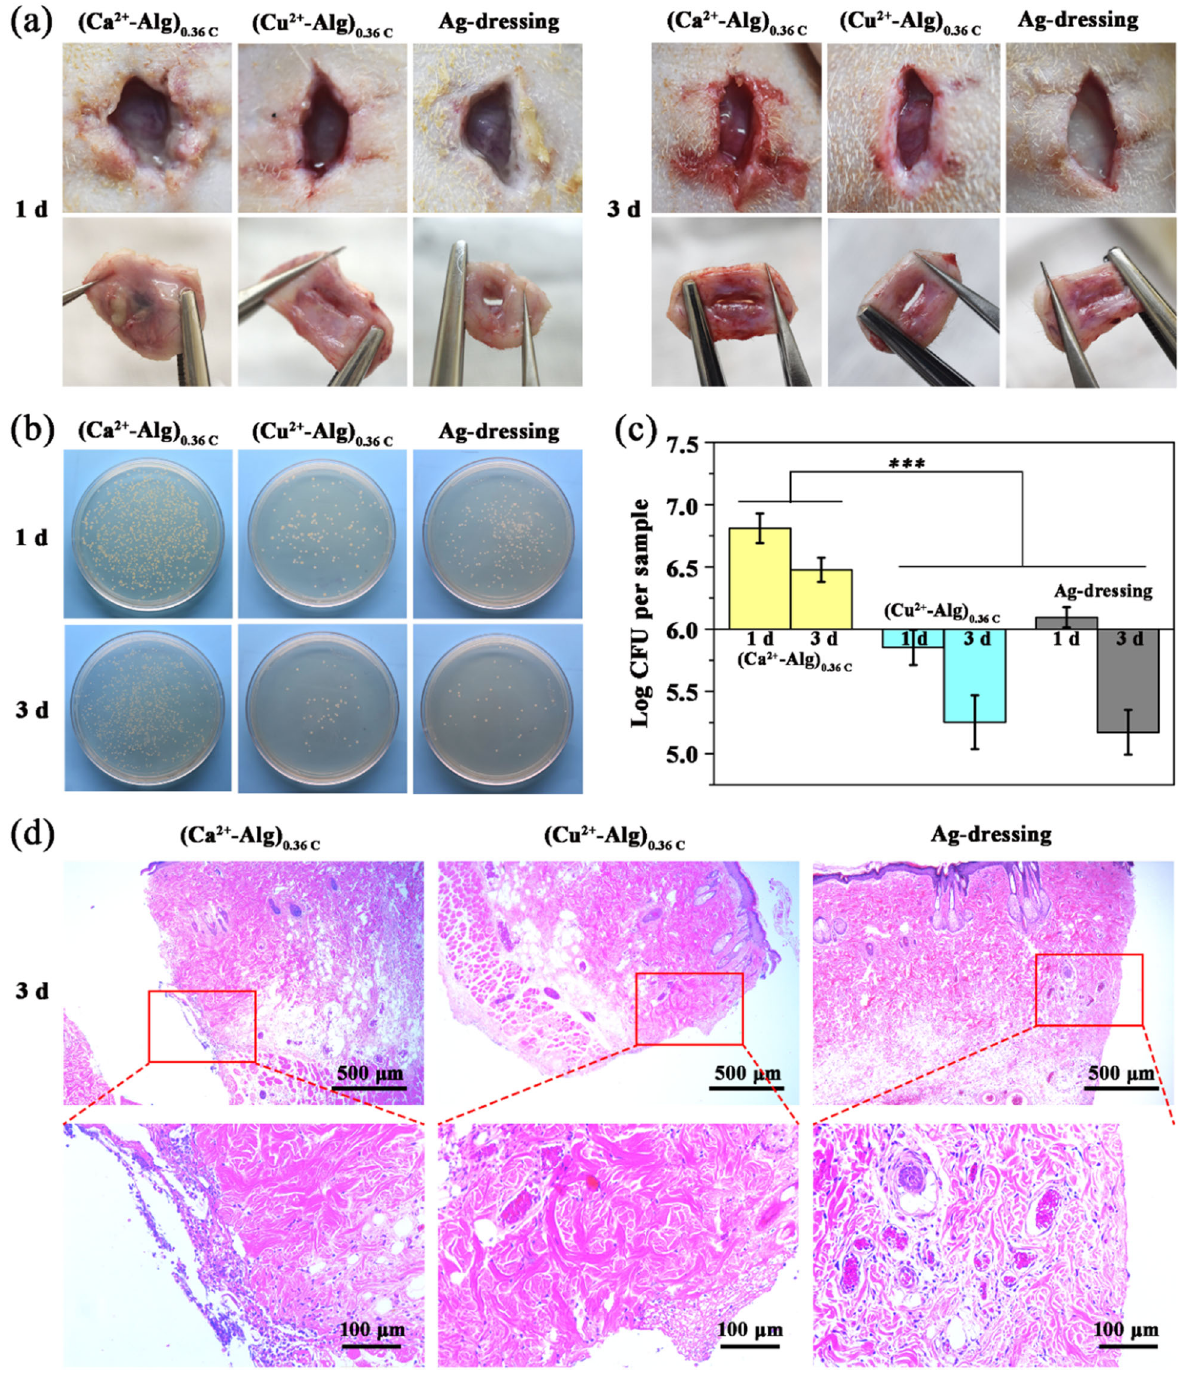
Fig. 6 In vivo antimicrobial studies by employing an infected SD rat model. a Photographs of re-opened incisions with different treatments after 1 day and 3 days. b Exudate bacterial plate counting and c Scale bar is 500 and 100 μ m,